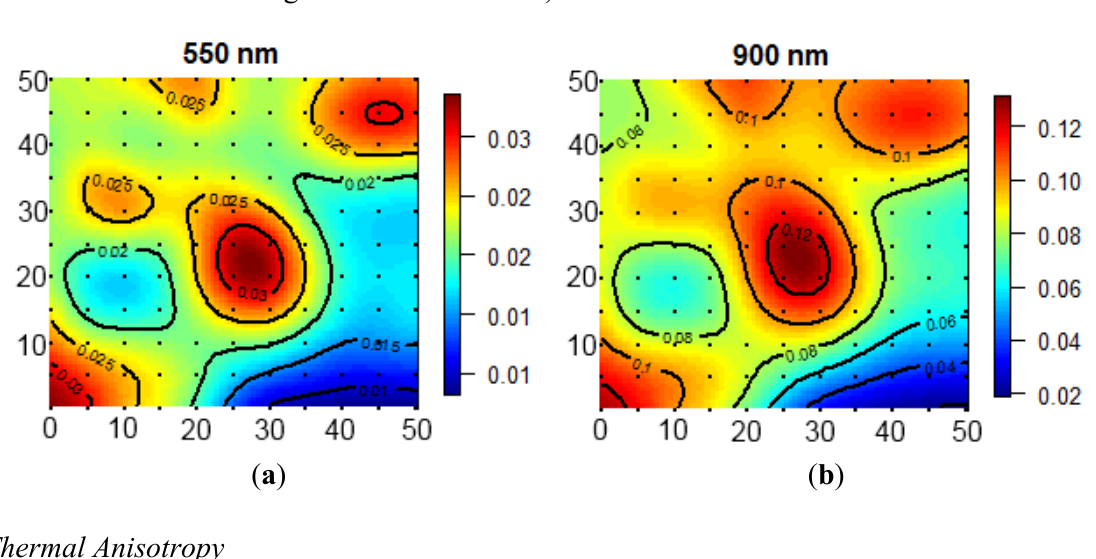
Figure 7. Interpolated biconical reflectance measurements of a 50 × 50 cm 2 area covered with small pine trees at ( a ) 550 nm, and ( b ) 900 nm (illumination angle close to nadir, constant view zenith angle = 0° in scan